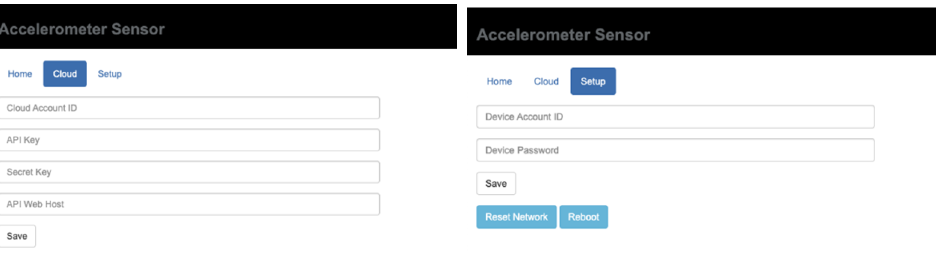
Figure 12. Cloud and setup tabs of sensor device user interface.